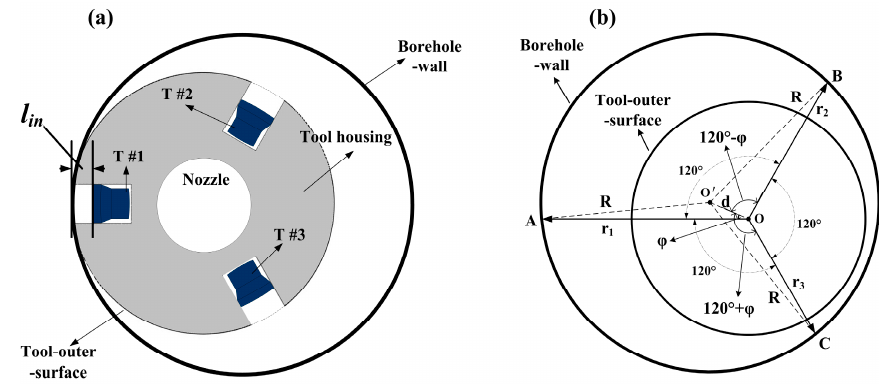
Figure 3. Profile map of the ultrasonic LWD caliper. ( a ) Transducer distribution; and ( b ) equivalent geometric relation graph of the transducer distribution.